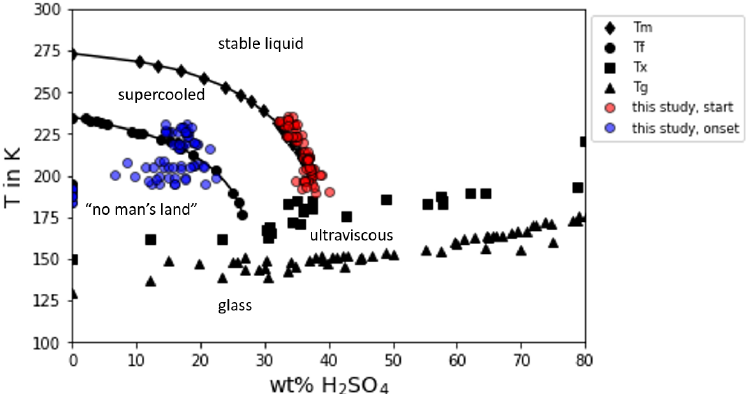
Figure D1. Phase diagram of sulfuric acid adapted from Koop (2004). The phase diagram of sulfuric acid as given by Koop (2004) and references therein is shown and complemented by the calculated weight percentage concentrations of the sulfuric acid aerosol particles before the start of the AIDA experiments of this study (red dots) and at the observed ice onset during the experiments (blue dots).